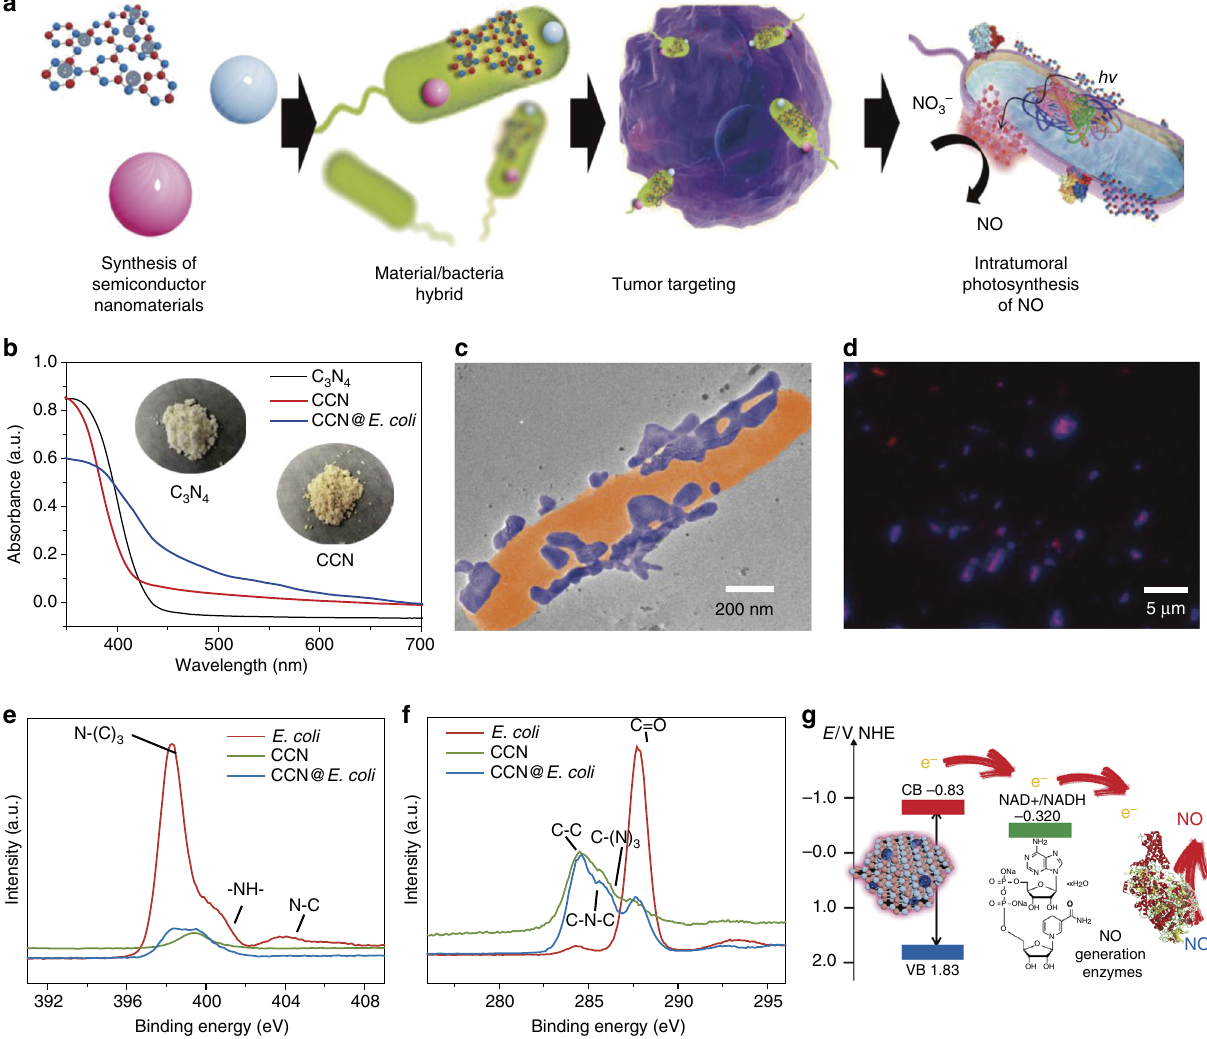
Fig. 1 Characterization of PMT system. a Schematic diagram of the preparation of PMT system. b UV − Vis absorption spectra of as-prepared CCN. c TEM image of CCN@ E. coli . d Spinning disk confocal microscope image of CCN@ E. coli (Blue: CCN; Red: E . coli ). e XPS de-convoluted spectra for the N1s orbitals of E. coli , CCN, and CCN@ E. coli . f XPS de-convoluted spectra for the C1s orbitals of E. coli , CCN and CCN@ E. coli . g Schematic illustration for